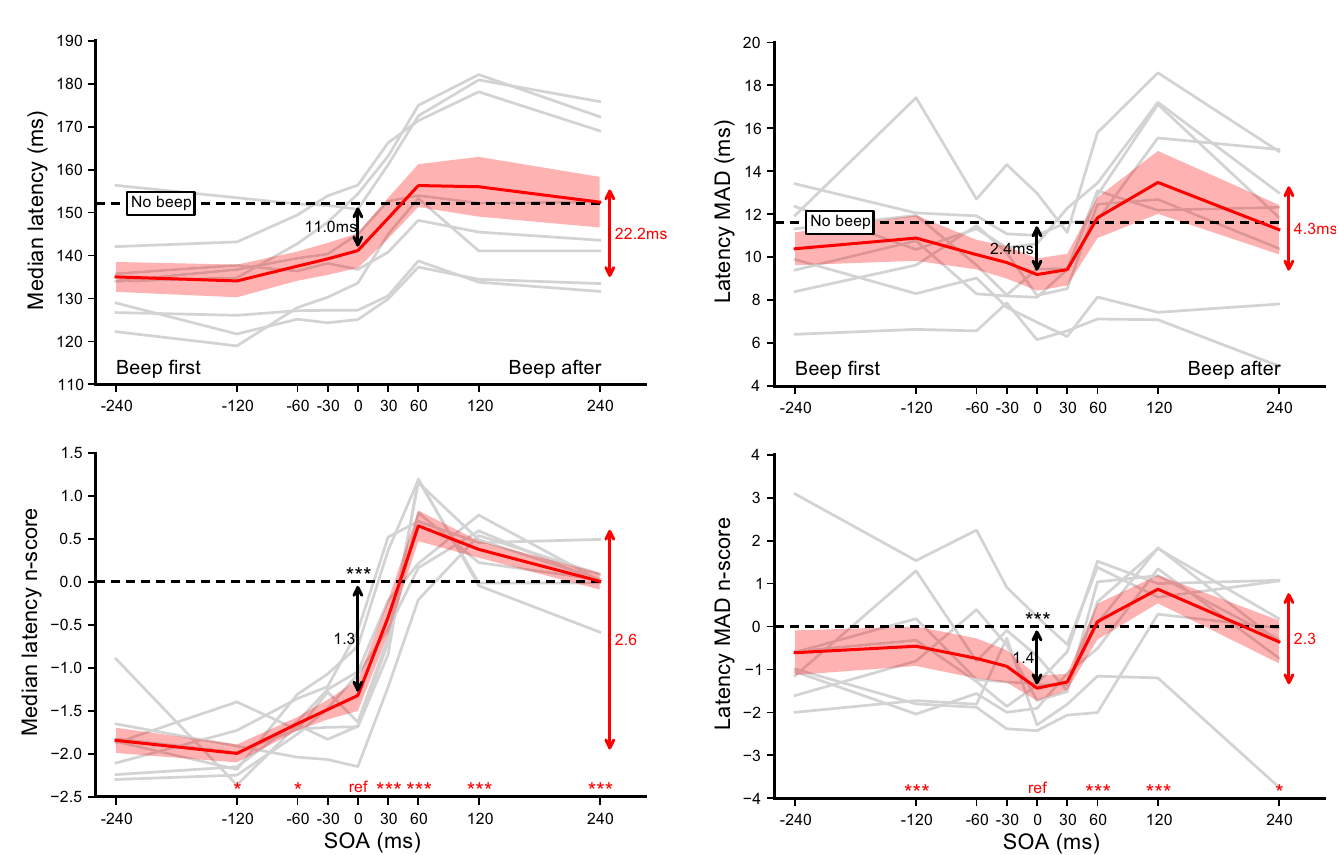
Fig 2. Experiment A. Effect of sound beeps on saccade onset. Median latencies (left panel) and median absolute deviations (right panel) averaged across participants for each SOA condition (top) and their corresponding n scores (bottom). Dashed lines show the No beep condition level and grey lines show individual results. Error bars indicate inter-individual SEM. Statistics included a single sample t-test performed on the n scores of the SOA = 0 ms reference condition to highlight the difference with the No beep condition (black arrow), and paired t-tests comparing this reference with each of the other SOA condition (red stars for each SOA above the X-axis). Three stars indicate highly significant differences after Bonferroni correction (p < 0.00555) while single stars significant differences without correction (p < 0.05). Red arrows indicate the overall range of